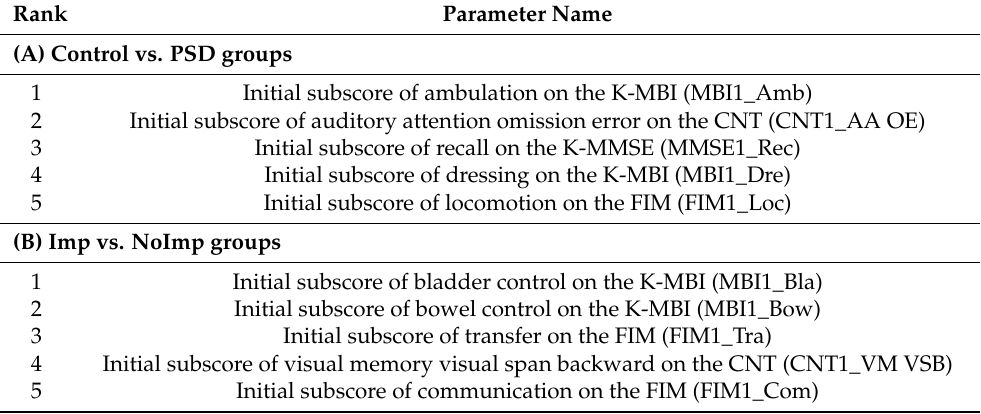
Table 8. Lists of feature selection for the prediction of PSD (control vs. PSD, A) and the prognosis of PSD (Imp vs. NoImp,